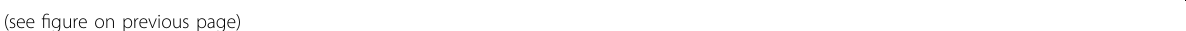
Fig. 3 Runx3 was involved in circ_0000296 and miR-194-5p-mediated neuronal apoptosis by (CCI. a The predicted miR-194-5p-binding site in Runx3 (Runx3-Wt) and the designed mutant sequence (Runx3-Mut) were indicated. Dual-luciferase reporter assay of HT22 cells cotransfected with Runx3-Wt or Runx3-Mut and Agomir-194-5p or the Agomir-194-5p-NC. Data represented as mean ± SD. ( n = 3), * P < 0.05 vs. Runx3-Wt + agomir-194- 5p-NC group. b , c Relative expression levels of Runx3 were measured by qRT PCR and western blot. Data represented as mean ± SD. ( n = 3), * P < 0.05 vs. HT22 in normal group. d , e Relative expression levels of Runx3 were measured by qRT-PCR and western blot after circ_0000296 overexpression. Data represented as mean ± SD. ( n = 3), * P < 0.05 circ_0000296( + )-NC group. f , g Relative expression levels of Runx3 were measured by qRT-PCR and western blot after miR-194-5p overexpression or knockdown. Data represented as mean ± SD. ( n = 3), * P < 0.05 vs. Agomir-194-5p-NC group. # P < 0.05 vs. Antagomir-194-5p-NC group. h , i Relative expression levels of Runx3 were measured by qRT-PCR and western blot after co-transfection with circ_0000296 and miR-194-5p. Data represented as mean ± SD. ( n = 3, each group) * P < 0.05 vs. circ_0000296( + )-NC + antagomir-194-5p-NC group. j Flow cytometry analysis of OGD-induced HT22 cells after Runx3 overexpression with annexin V/PI staining. Data represented as mean ± SD. ( n = 3, each group) * P < 0.05 vs. Runx3( + )-NC